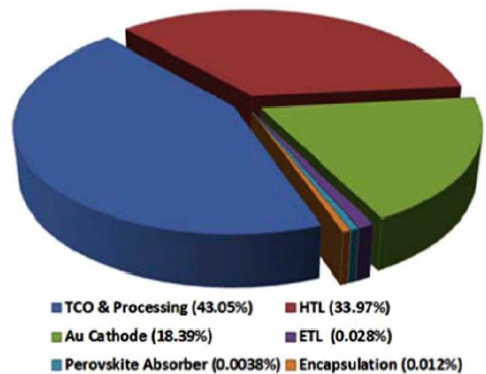
Figure 10. Price sharing of precursors of each layer of a conventional PSC [104].